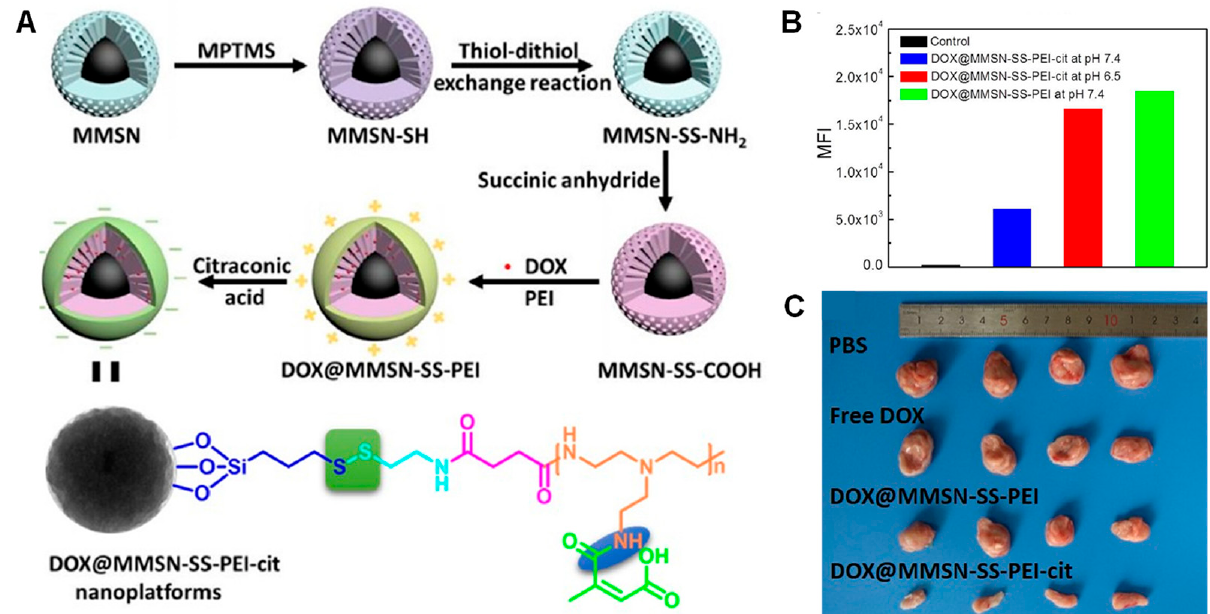
Figure 6. ( A ) Schematic representation of synthesis of the redox-responsive masked MSNs. ( B ) Application of acid pH results in amine exposure and subsequent enhanced uptake. ( C ) The in vivo experiments showed that the system containing the redox- and pH-responsive bonds exerted the highest toxicity. Adapted with permission from [41]. Copyright Elsevier, 2020.